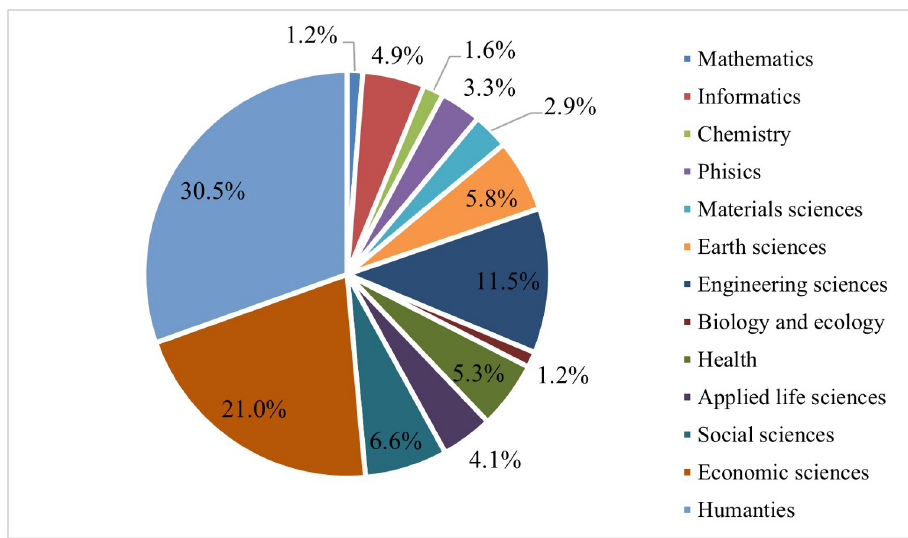
Fig 3. Specific areas of interest of the respondents. Source: authors own